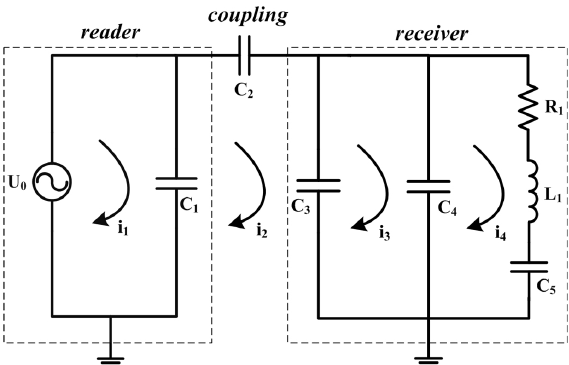
Figure 6. Simplified linearized equivalent circuit model of the ca- pacitive coupler connected to a SAW